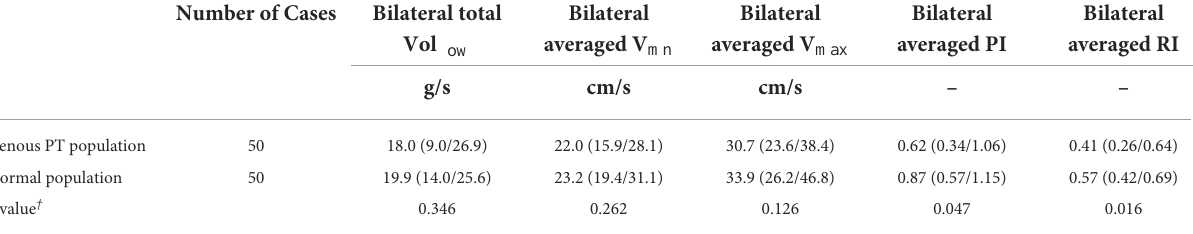
TABLE 5 Jugular hemodynamics of 50 venous PT subjects and 50 healthy